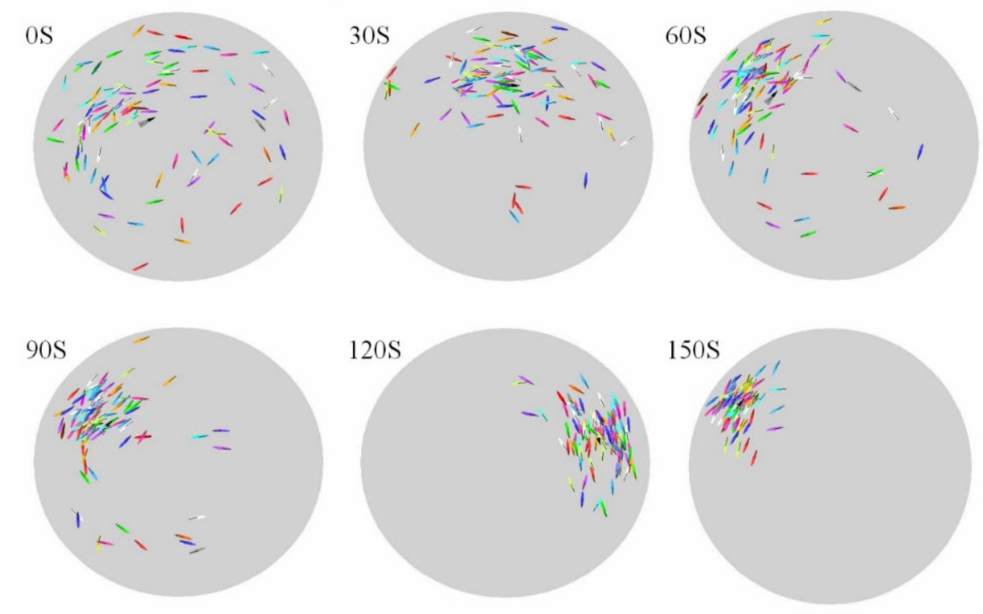
Figure 9. Six sequential frames of the 100-agent simulation for the aggregation of collective